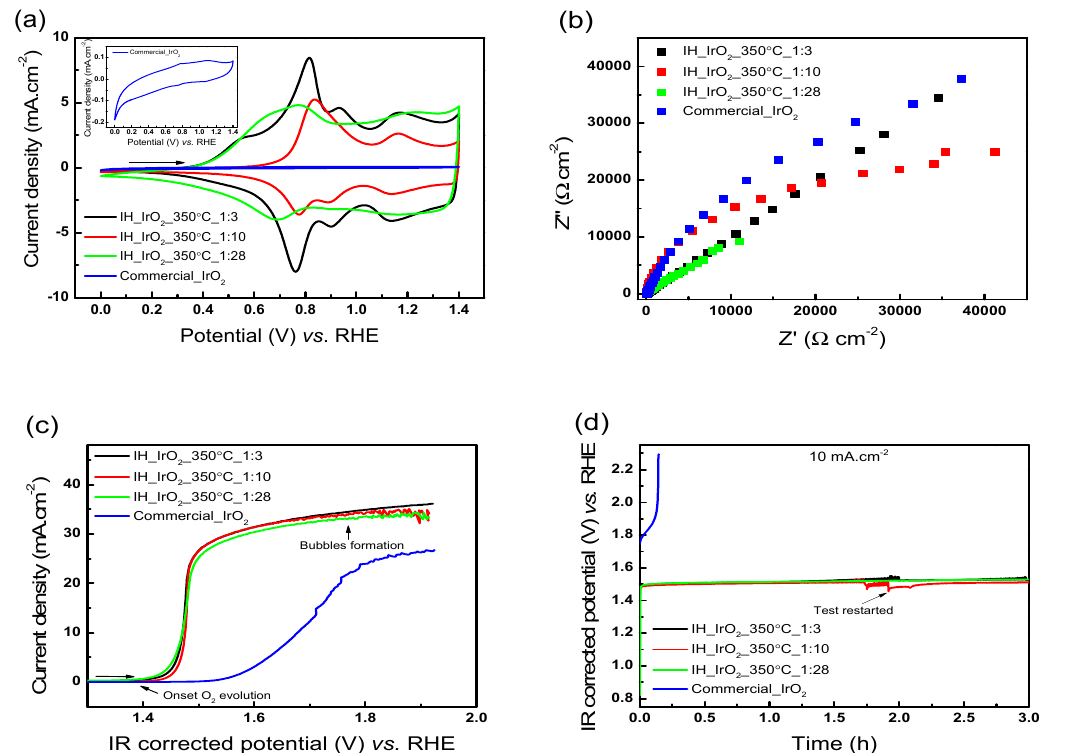
Figure 4. Electrochemical analyses of the in-house IrO 2 synthesized using various H 2 IrCl 6 ·xH 2 O to NaNO 3 ratios and commercial IrO 2 ( a ) Cyclic voltammetry (CV) analysis at 20 mV·s − 1 potential scan rate, ( b ) Electrochemical impedance (EIS) analysis, ( c ) Linear sweep voltammetry (LSV) analysis at 2 mV·s − 1 and ( d ) Chronopotentiometry (CP) analysis at 10 mA·cm − 2 .